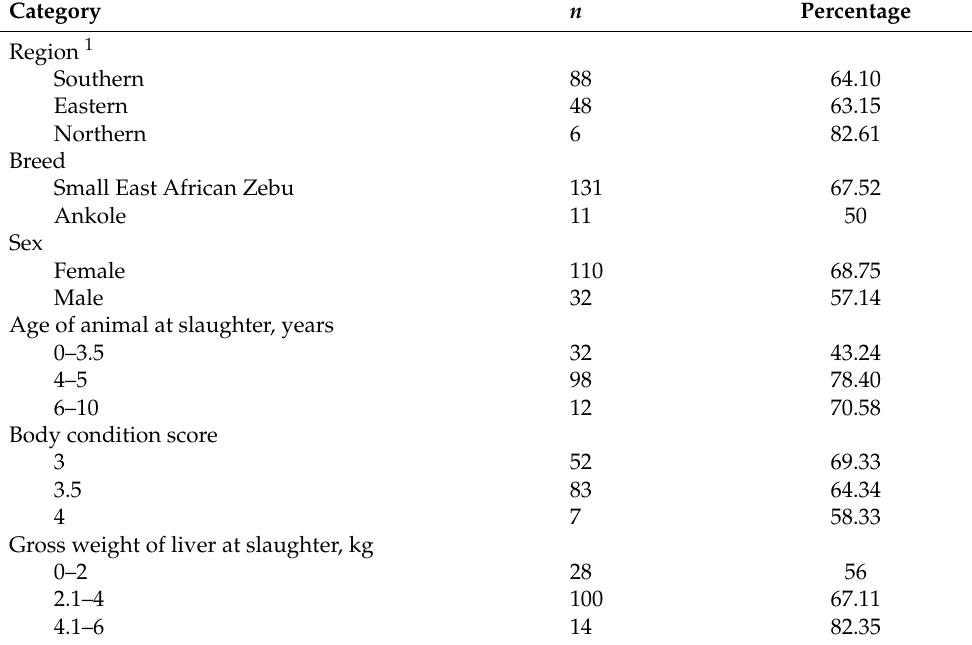
Table 2. Prevalence of fascioliasis in examined cattle ( n = 142) assessed by region, breed and sex, age, and source of